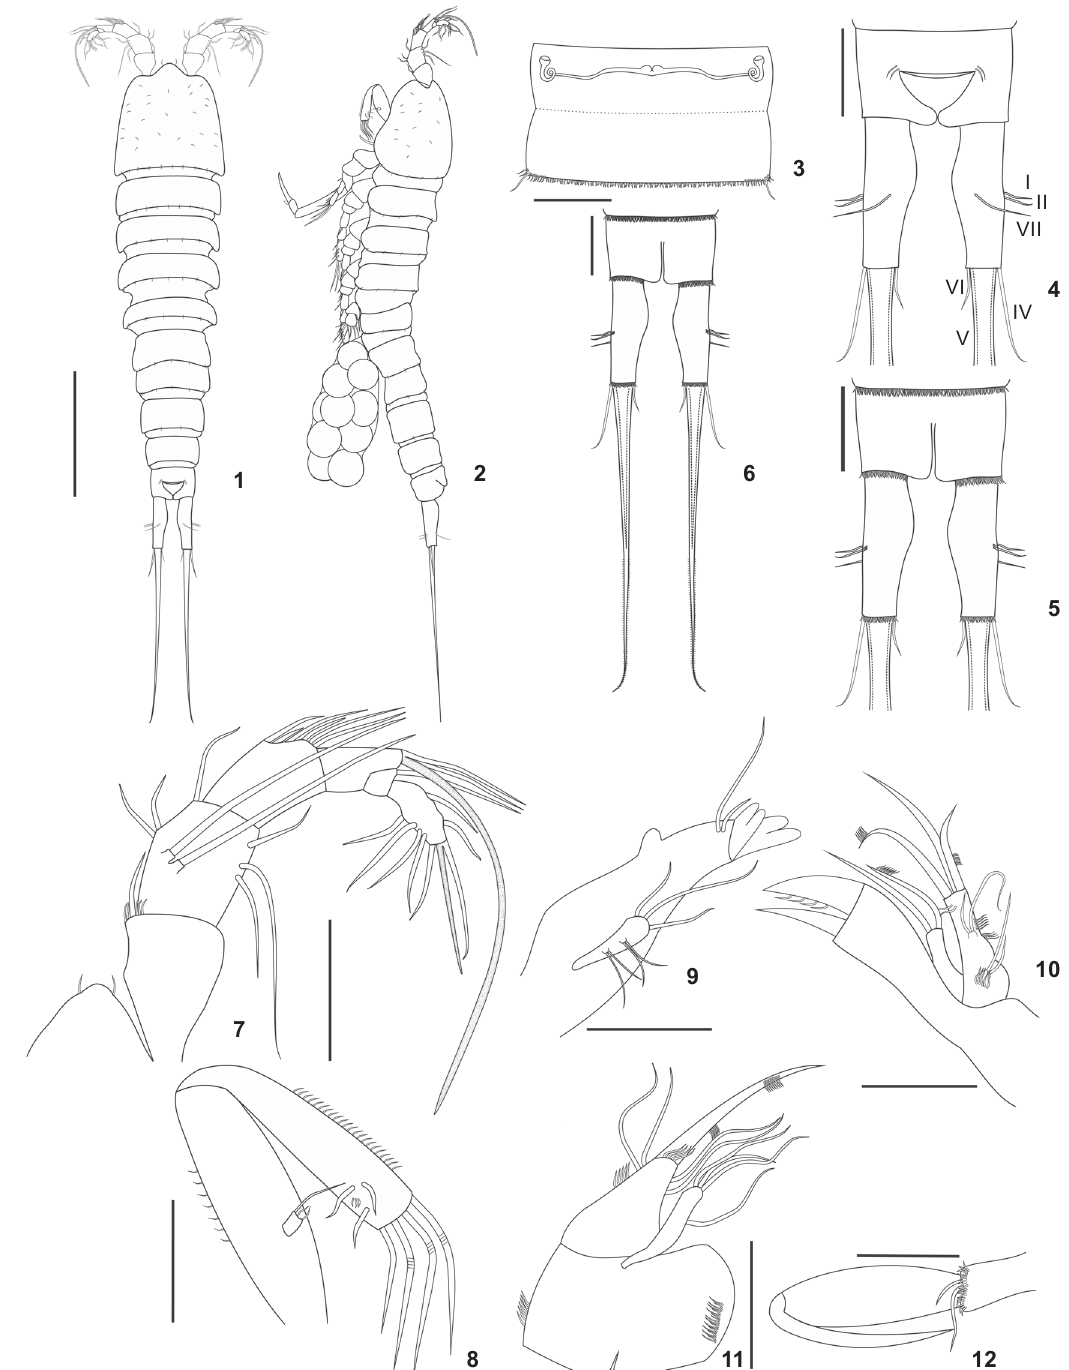
Figures 1-12. Quinquelaophonte aestuarii sp. nov. , female holotype: (1) habitus, dorsal; (2) habitus, lateral; (3) genital field, ventral view; (4) furcal rami, dorsal view with anal operculum and furcal setae; (5) furcal rami, ventral view; (6) anal somite and furcal rami; (7) antennule and rostrum, ventral view; (8) antenna, anterior view; (9) mandible, anterior view; (10) maxillule, anterior view; (11) maxilla, anterior view; (12) maxilliped, anterior view. Scale bar: 1-2 = 0.15 mm, 3-6 = 0.05 mm, 7 = 0.015 mm, 9-12 = 0.025 ZOOLOGIA 31 (5): 496–502, October, 2014